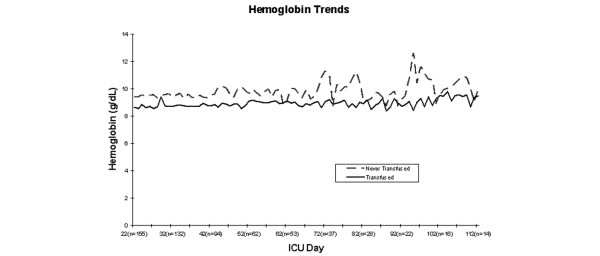
Hemoglobin trend over time by transfusion status. ICU, intensive care unit.